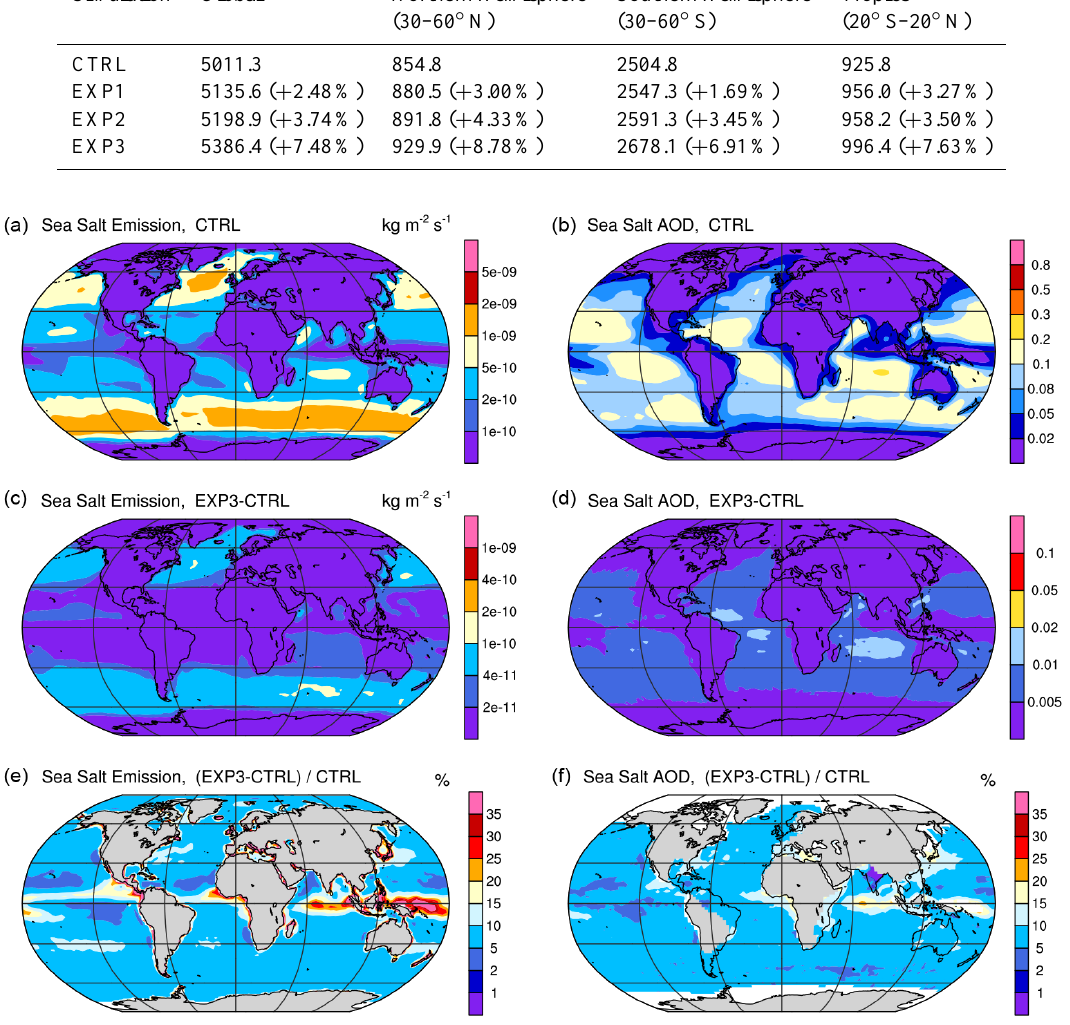
Figure 15. Top row: year 2006 mean sea salt emission flux (kgm − 2 s − 1 ) and sea salt AOD (unitless) at 550nm in the nudged CAM5 simulation (CTRL); Second row: differences between EXP3 and CTRL. Bottom row: relative differences between EXP3 and CTRL. In the bottom row, locations that have emission fluxes less than 1 × 10 − 12 kgm − 2 s − 1 or sea salt AOD < 0 . 01 in the CTRL simulation are masked